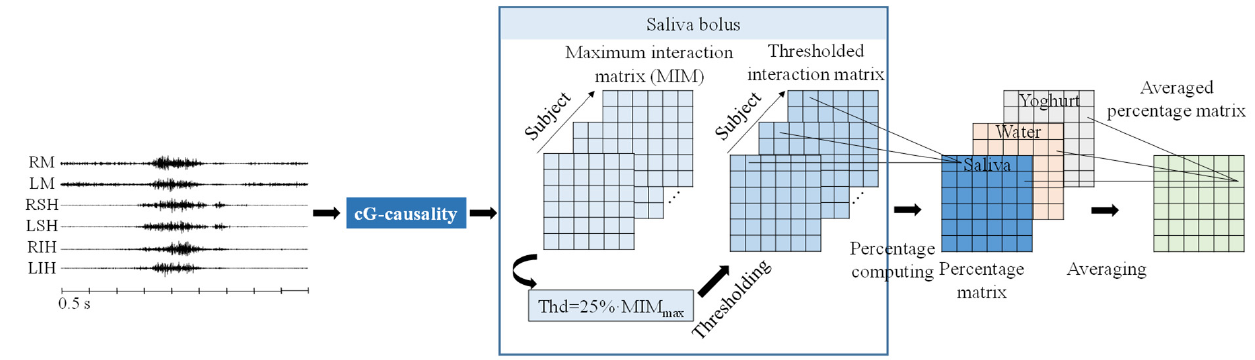
Figure 2. Flowchart of relevant interaction pairs with relatively high coupling strengths.